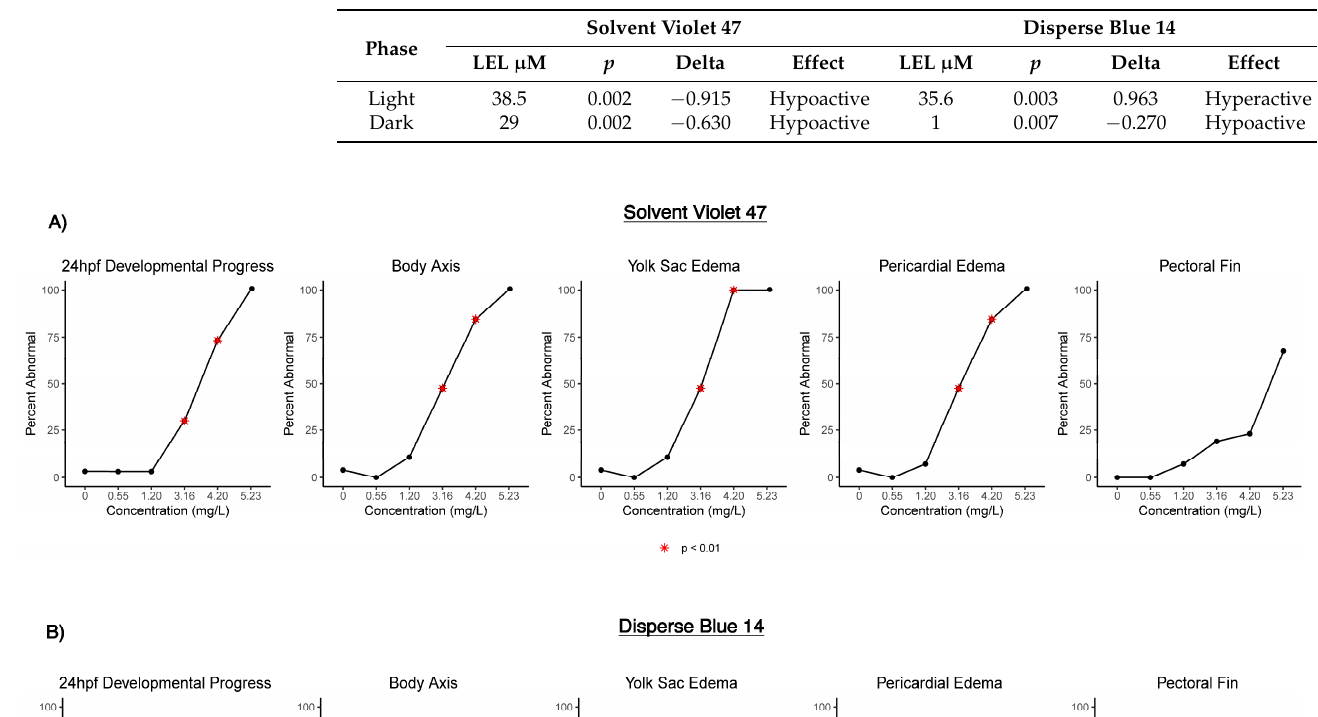
Table 2. Lowest Effect Levels (LEL) and Kolmogorov–Smirnov (P) p -values for movement. Delta = (Average Treatment Movement − Average Control Movement)/(Average Control Movement).